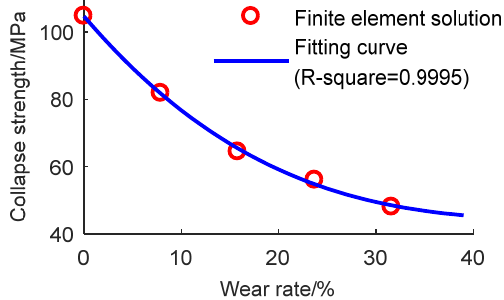
Figure 13. Finite element calculation results and fitting curve.